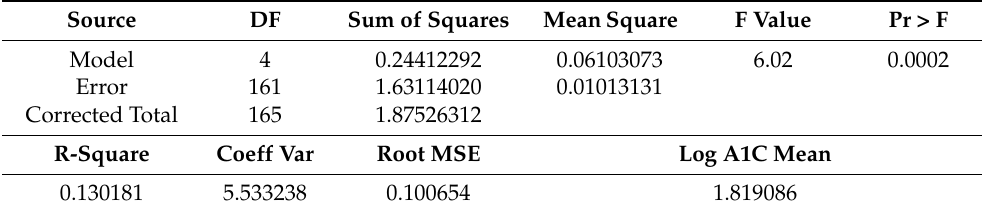
Table A6. GLM with log A1C < 1.95% (log < 7% equivalent) as dependent variable.